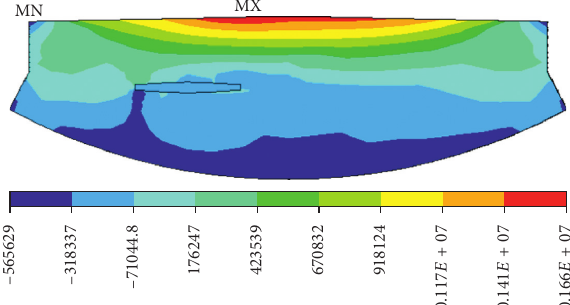
Figure 12: First principal stress of tunnel substructure (Pa) after the treatment.